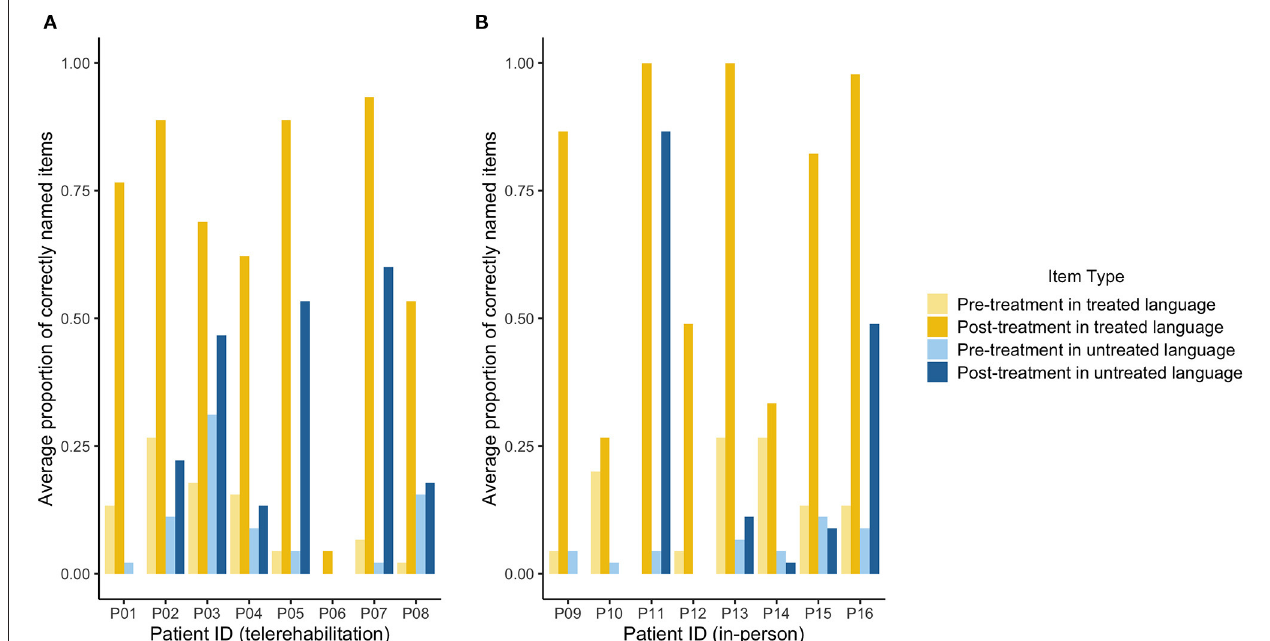
FIGURE 3 | Pre and post treatment naming scores for the telerehabilitation group and the in-person therapy group. The average proportion of correctly named items across three naming probes is shown for treated items (yellow) and untreated control items (blue) prior to treatment (lighter colors) and after treatment (darker colors) for each patient in the telerehabilitation group (A) and the in-person therapy group (B) .